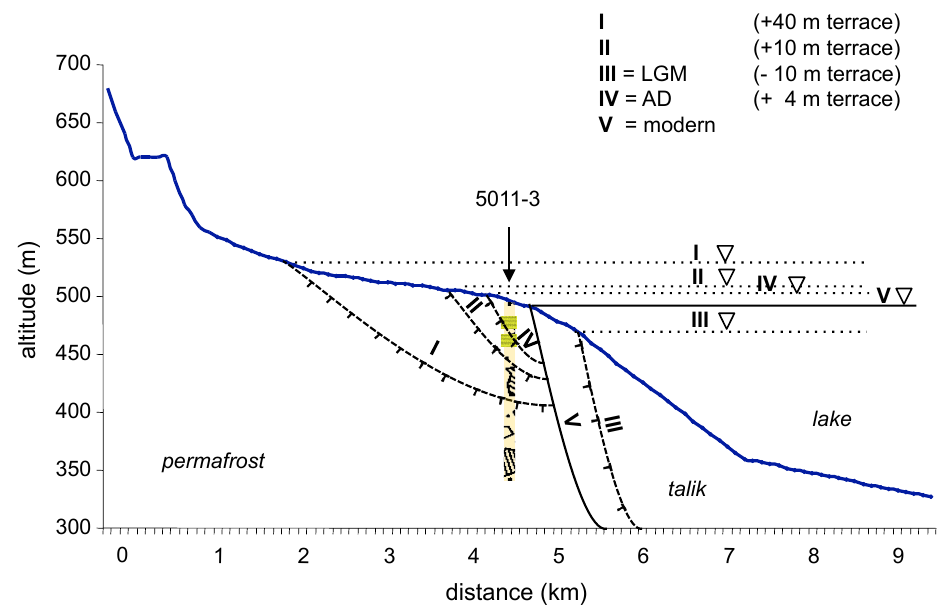
Figure 7. Interpretation of talik migration and associated repeated thaw and refreeze based on known Quaternary lake level fluctuations at the western edge of Lake El’gygytgyn. This scheme does not account for hiatuses or unconformities in the sediment and ground-ice